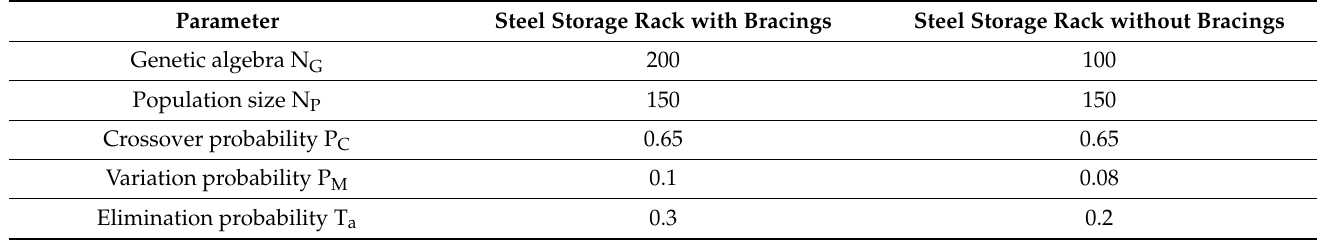
Table 2. Related parameters in GA.